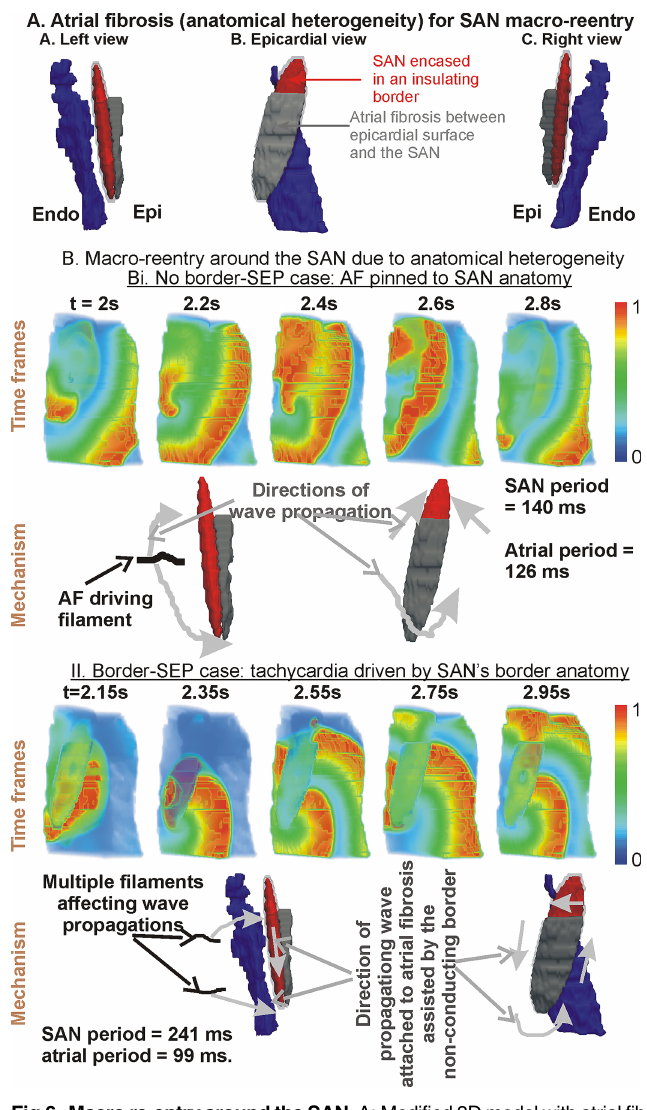
Fig 6. Macrore-entryaround the SAN. A: Modified3Dmodelwithatrial fibrosisbetweentheSAN and epicardialsurface.B: Simulationof macrore-entry.Bi showsdatawhereinsulating borderwas omitted,where the initiatedmacrore-entryinducedatrialfibrillation. Bii showsdatawheninsulating border-SEPs configuration wasincludedwhereatrial flutterwas observed. In each,Bi andBi, top rowshowstime frames from the simulation andbottomrow illustratesthe mechanism.The periodsfor SAN andatrialpacingin eachsimulation is alsogiven.